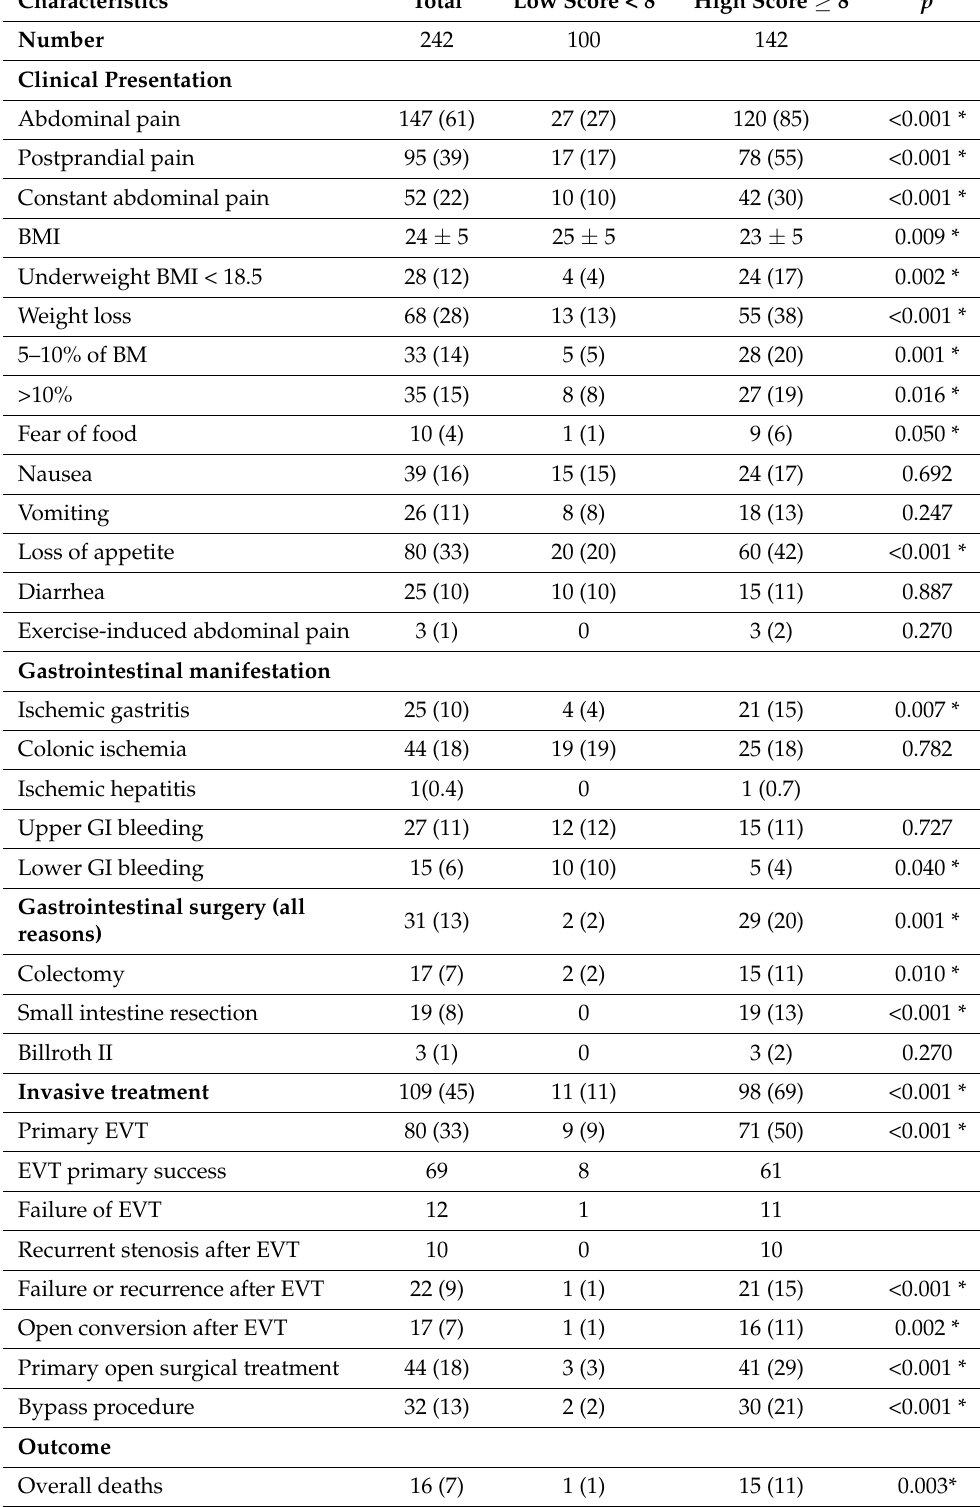
Table 2. Clinical presentation, gastrointestinal manifestations, and